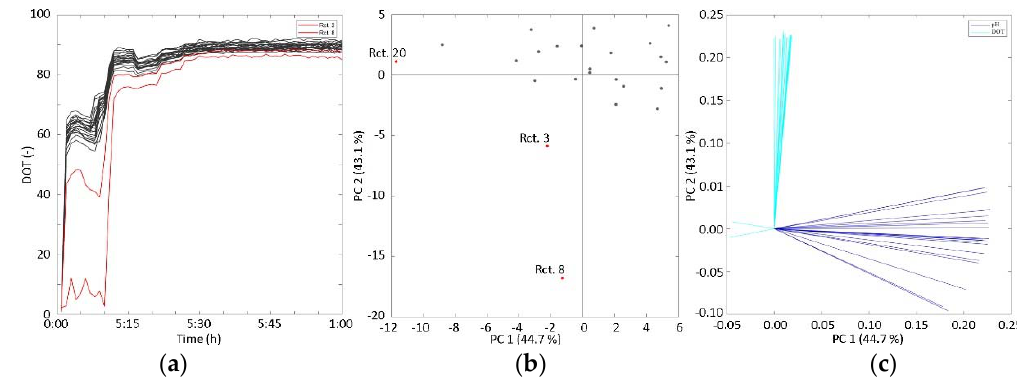
Figure 5. Detection of stirrer failures. ( a ) Trajectories for DOT and pH for all 24 reactors in the first hour of the cultivation. ( b ) Score plot for the sliding window PCA model with DOT and pH trajectories as input variables. The timeframe is t 0 = 0 to t end = 20 min. Reactors 8 and 20 are distinctly separated from the main cluster. The variance explained by the PC is indicated in percent in parenthesis. ( c ) Loadings of the first two principal components for the same PCA model.